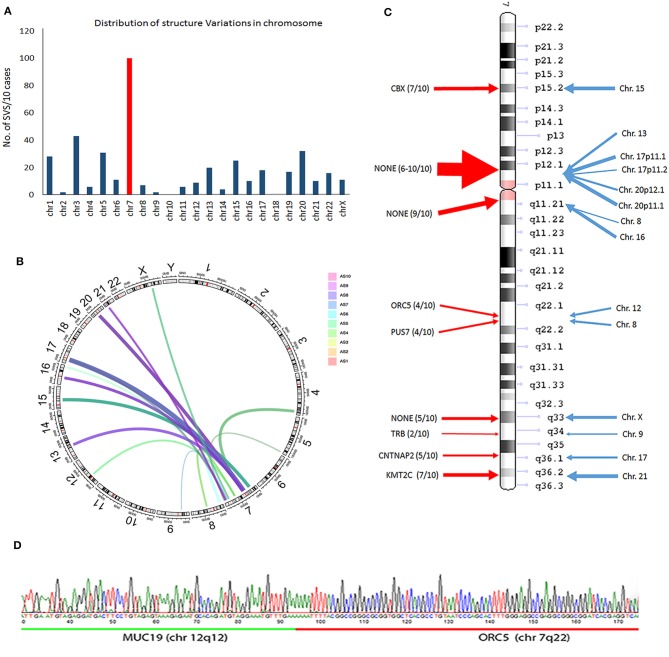
Frequent structure variation (SV) changes in chromosome 7. (A) Histoplots show the number of SV changes in each chromosome (chr 7 is in red). (B) Circos plot illustrates the inframe gene and genomic rearrangement between chr 7 and other chr partners (assembled from 10 cases; line thickness indicates the relative frequency of SV). (C) SV distribution and number of SV changes (thickness of arrows) in chr 7 (red arrows) region and other chr partners (blue arrows). The candidate genes in each SV region are listed. (D) An example of SV changes validated by PCR and Sanger sequencing analysis through two different gene fusion regions (upstream gene in green; downstream gene in red).